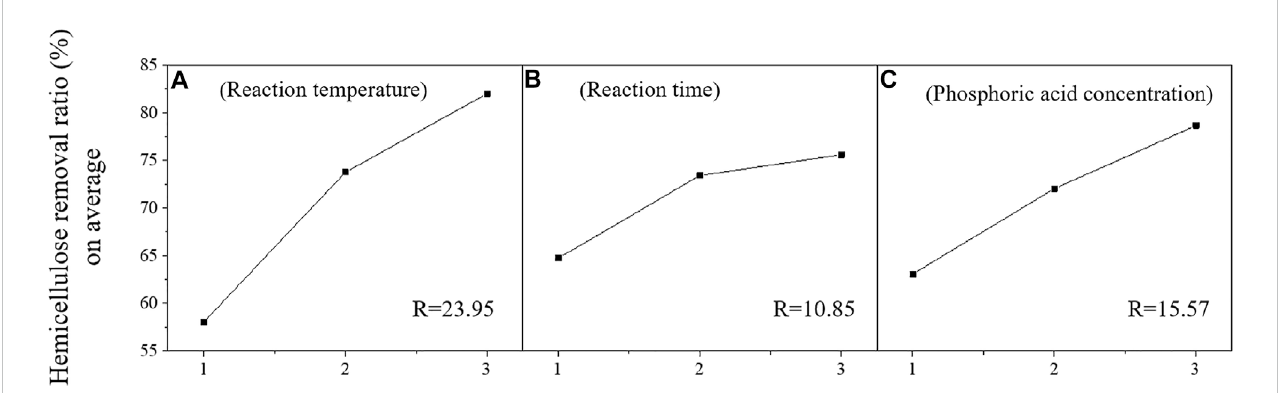
FIGURE 2 Analysisoforthogonalexperimentfactorsonhemicelluloseremovalratio[reactiontemperature (A) ,reactiontime (B) ,andphosphoricacidconcentration (C) ].